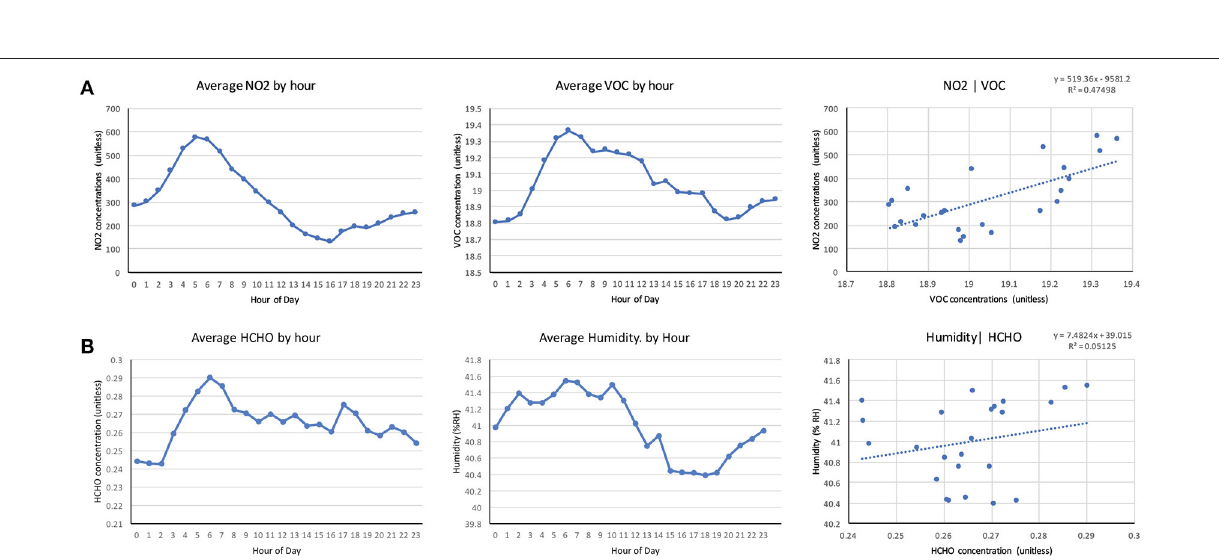
FIGURE 6 | All iEQ parameters measured at the west location in the PhD student office (PhD West) over the full duration of the ACEE experiment (Except ozone).